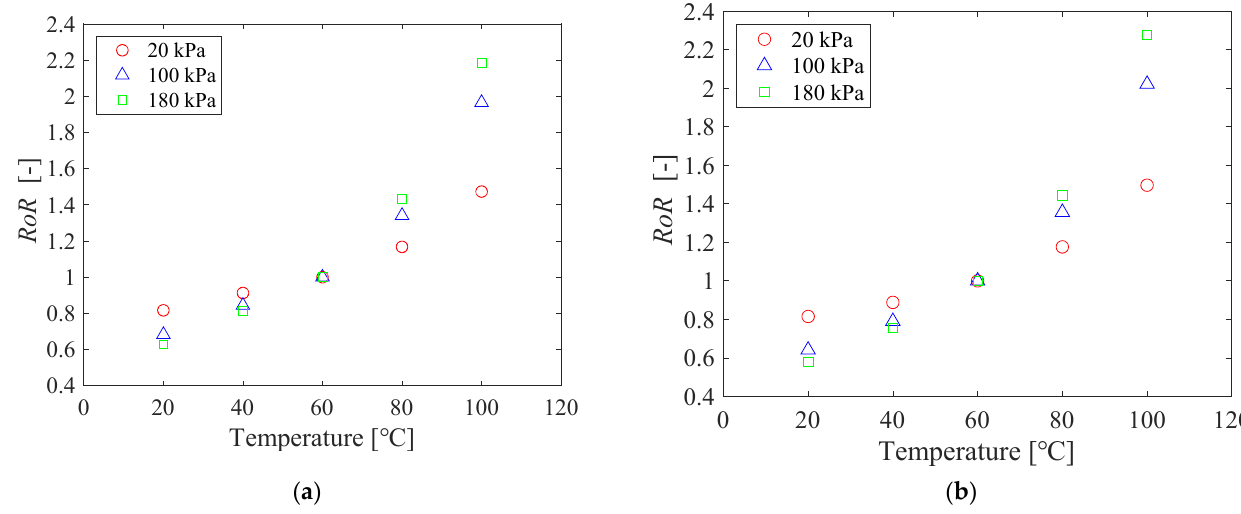
Figure 7. The relationship between the temperature and the RoR of PC-PSP ( a ) before and ( b ) after the heat treatment.